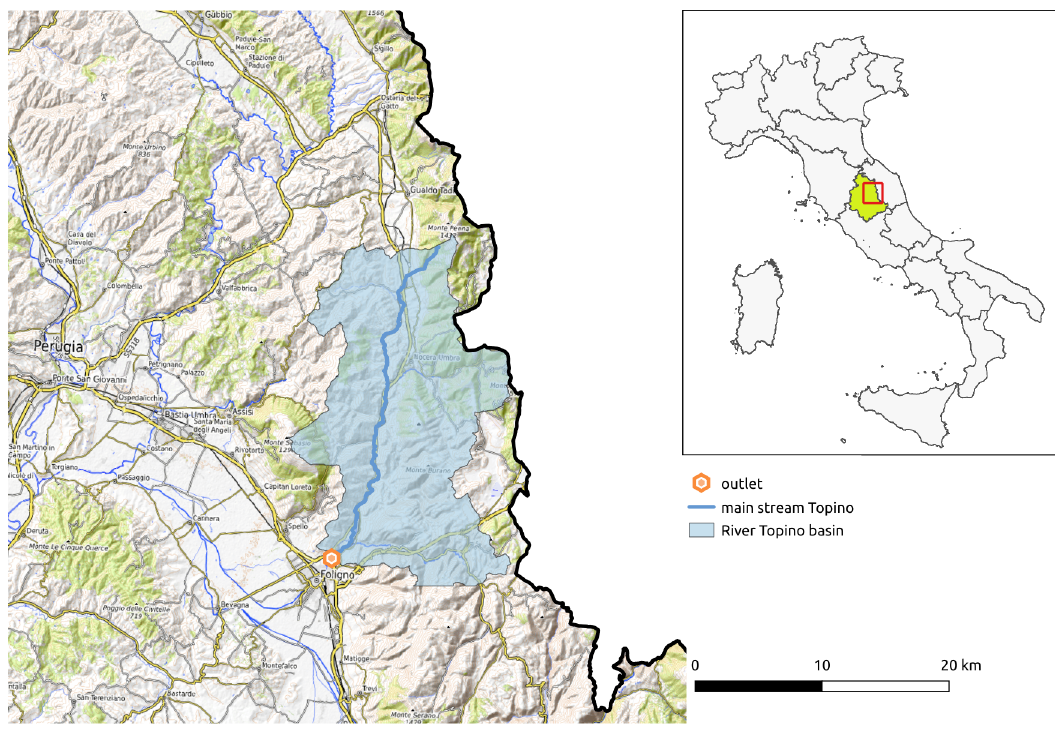
Figure 2. Hydrographic basin of Topino. The blue line represents the Topino River. The red rectangle on the right represents the coverage